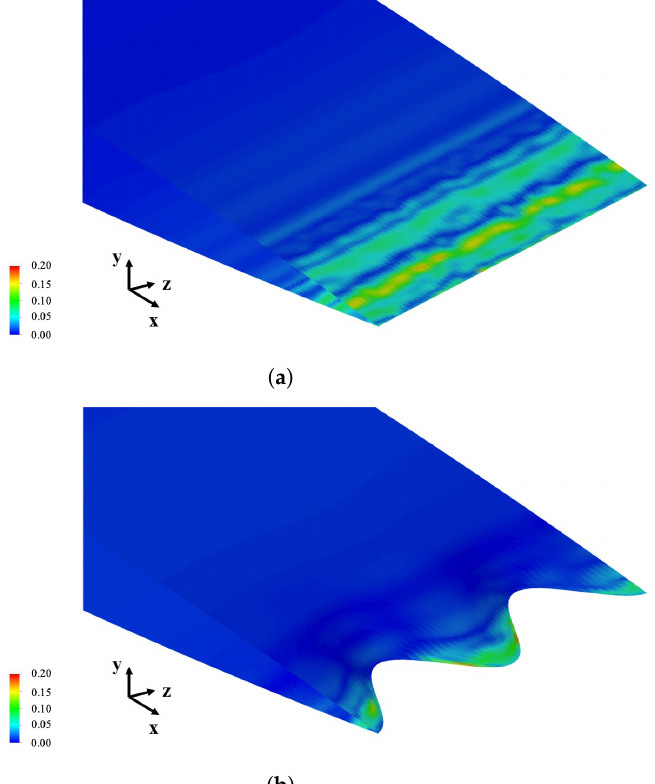
Figure 11. Profile of the pressure fluctuation near the trailing edge: ( a ) NACA0012 airfoil: and ( b ) serrated